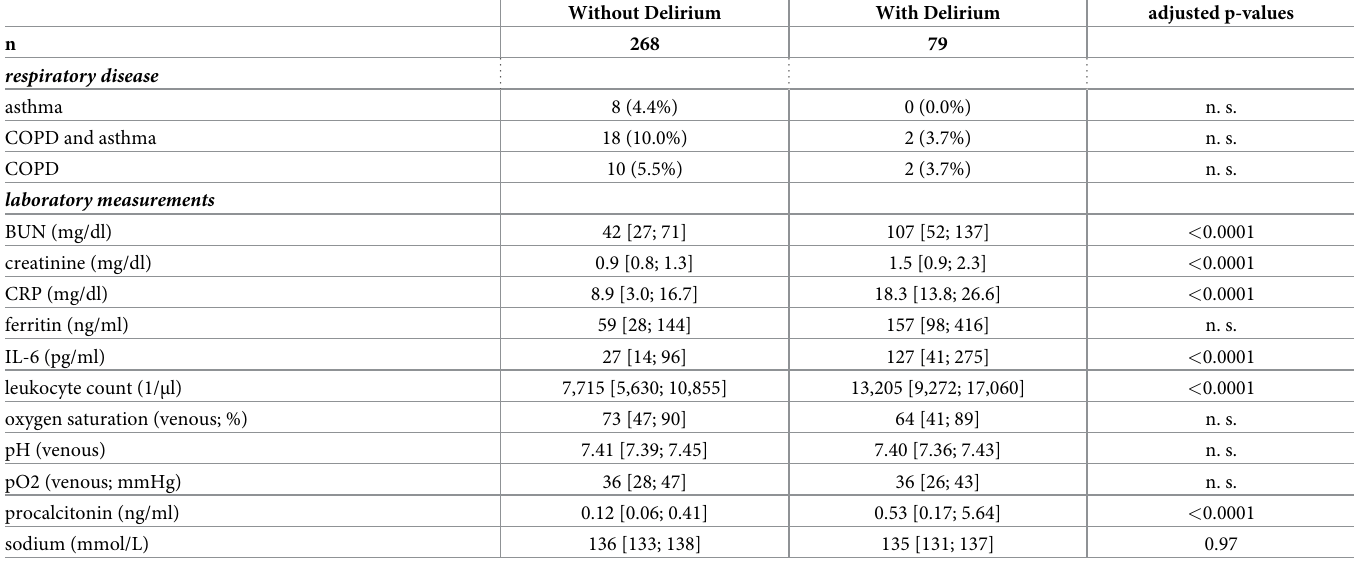
ated with systematic differences in patients’ neuroradiological findings.